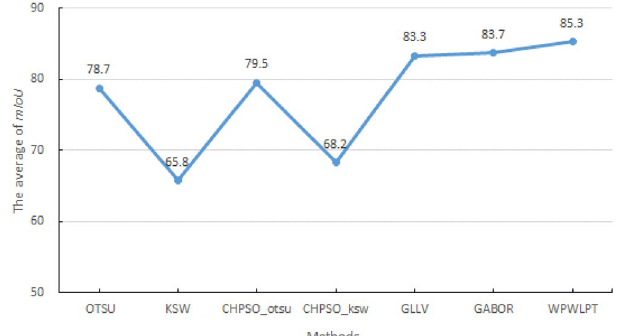
Figure 7. The average mIoUs (%) of different methods.